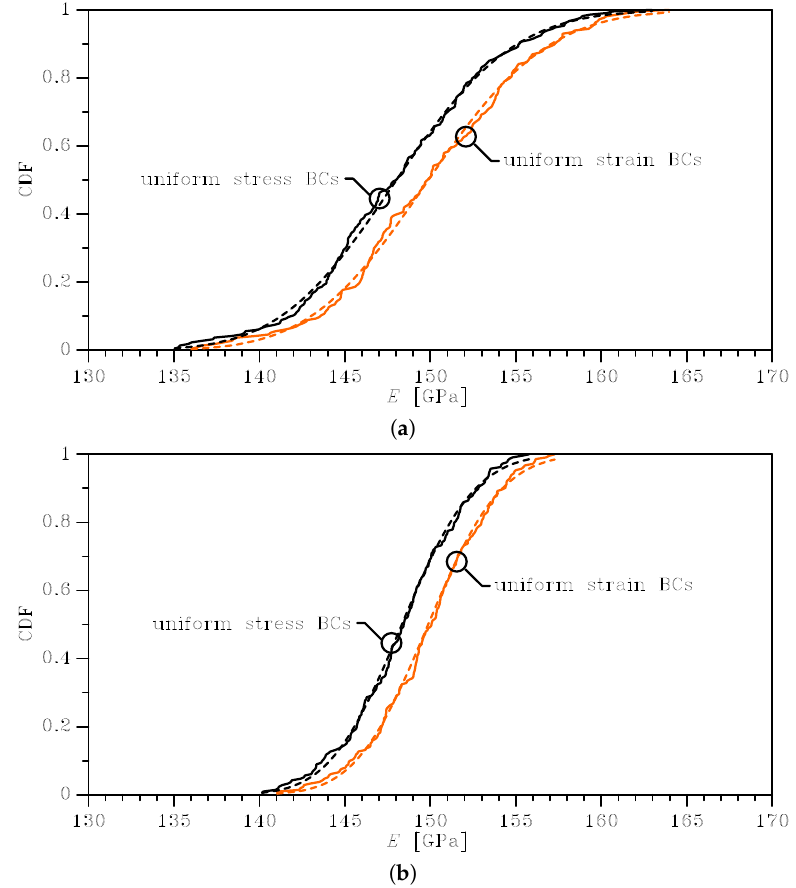
Figure 3. Effects of SVE size and BCs on the cumulative distribution function of the homogenized Young’s modulus: ( a ) 2 × 2 µ m 2 SVE and ( b ) 3 × 3 µ m 2 SVE. Continuous lines represent the results of MC analyses, whereas dashed lines are the relevant lognormal interpolants.